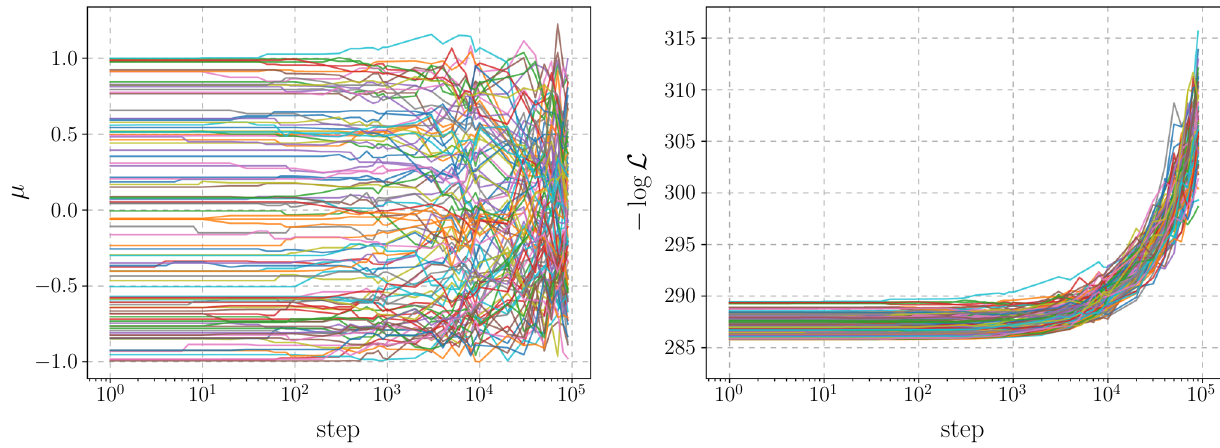
minus log-likelihood − log L (right) versus the number of steps for a random subset of 100 of the 200 chains. For visualization purposes, values in the plots are computed only for numbers of steps included in the set { a × 10 b } with a ∈ [ 1 , 9 ] and b ∈ [ 0 , 6 ]